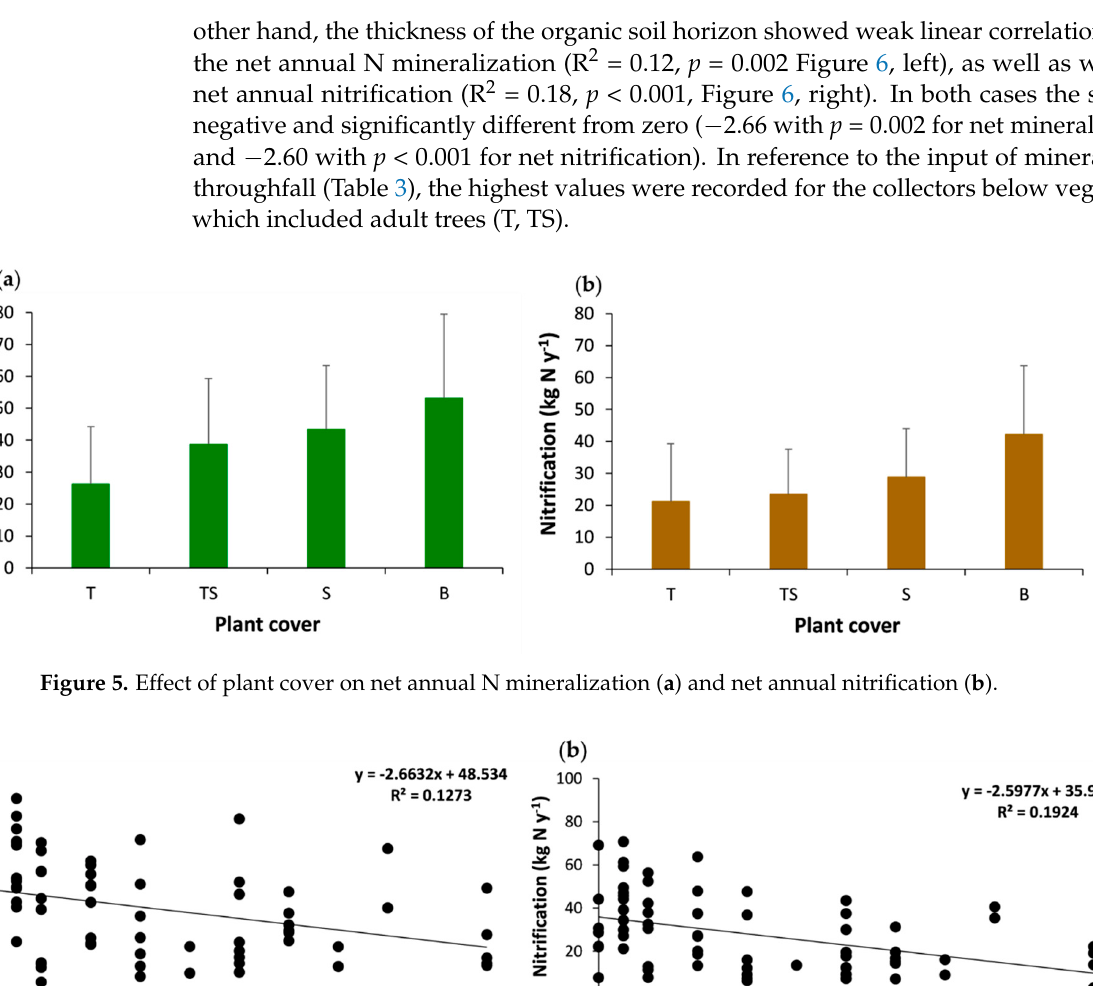
Figure 6. Effect of the organic soil horizon thickness on net annual N mineralization ( a ) and net annual nitrification ( b ).